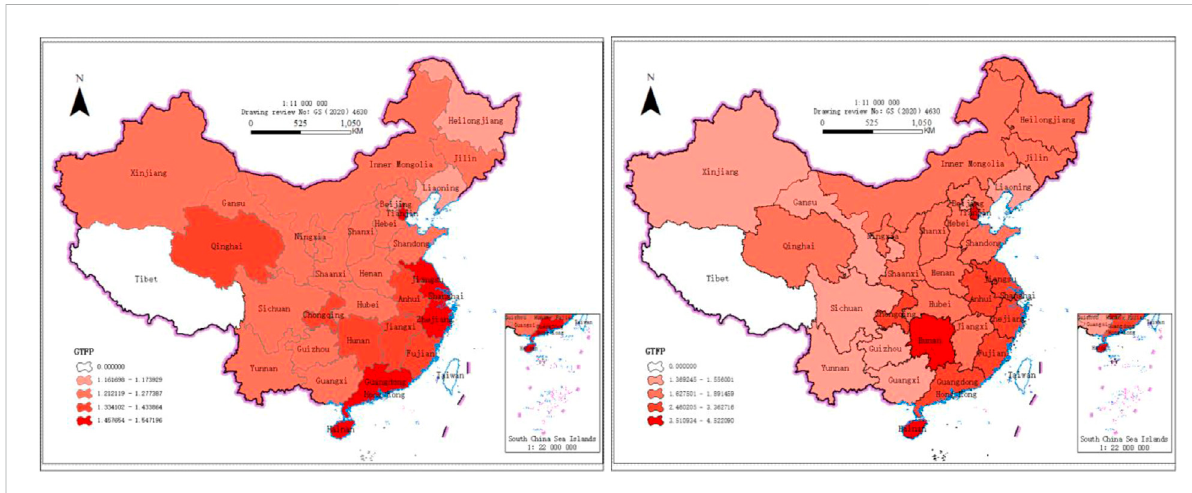
FIGURE 2 The average level of green technology innovation in each province from 2006 to 2020 (left) and the level of green technology innovation in 2020 by province